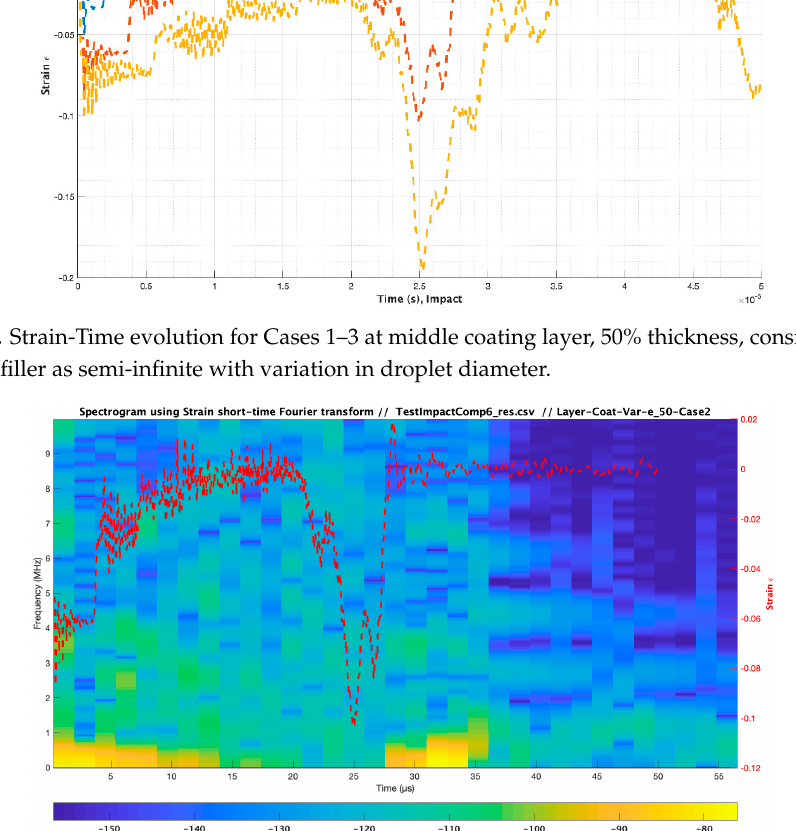
Figure 32. Spectrogram for strain evolution at the middle coating layer, 50% thickness, considering substrate-filler as semi-infinite with variation in droplet diameter. Case 2.